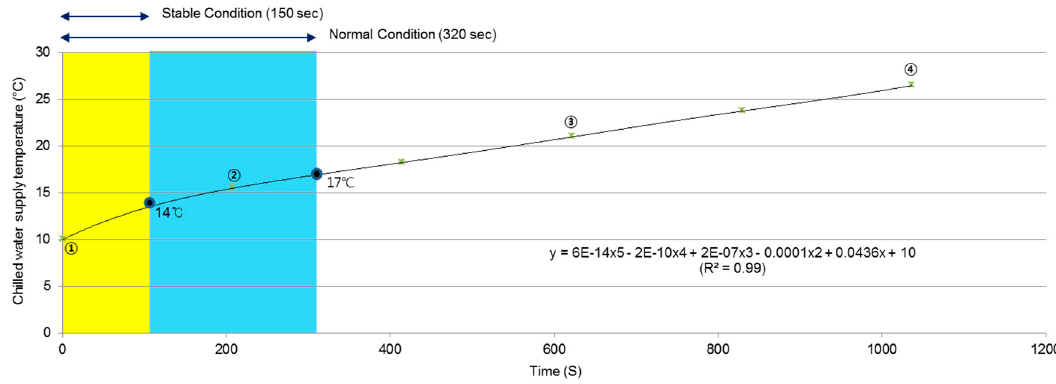
Figure 13. Chilled water temperature as a function of time under fault conditions.